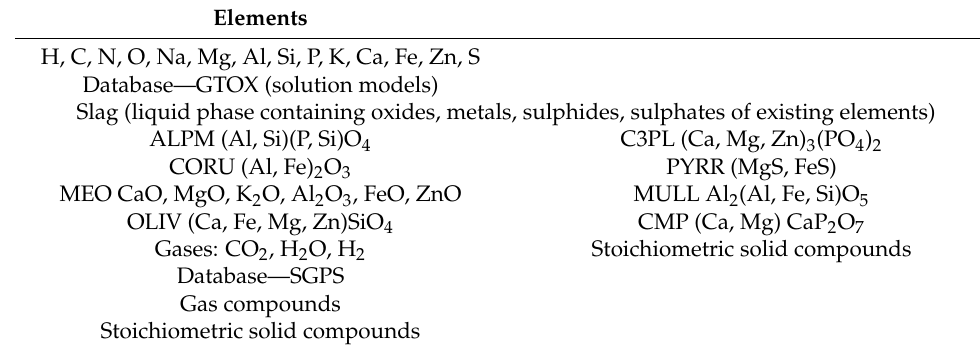
Table 2. Elements, compounds, and solution models used for the thermodynamics equilibrium calculations in FactSage.